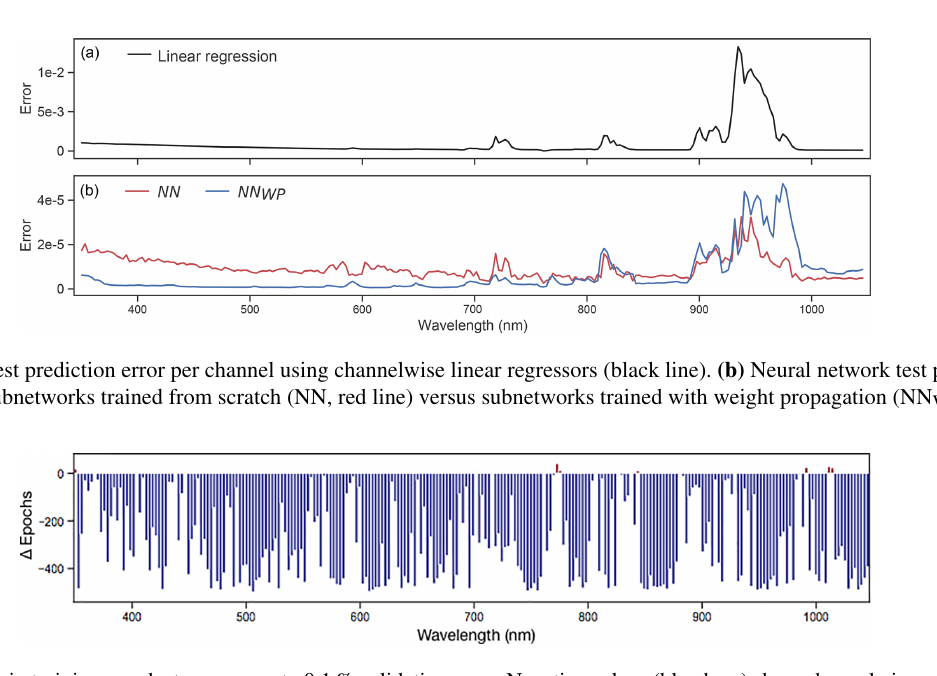
Figure 4. Difference in training epochs to converge to 0.1% validation error. Negative values (blue bars) show channelwise subnetworks that converged faster using weight propagation, while positive values (red bars) indicate channels whose subnetworks converged more quickly when trained from